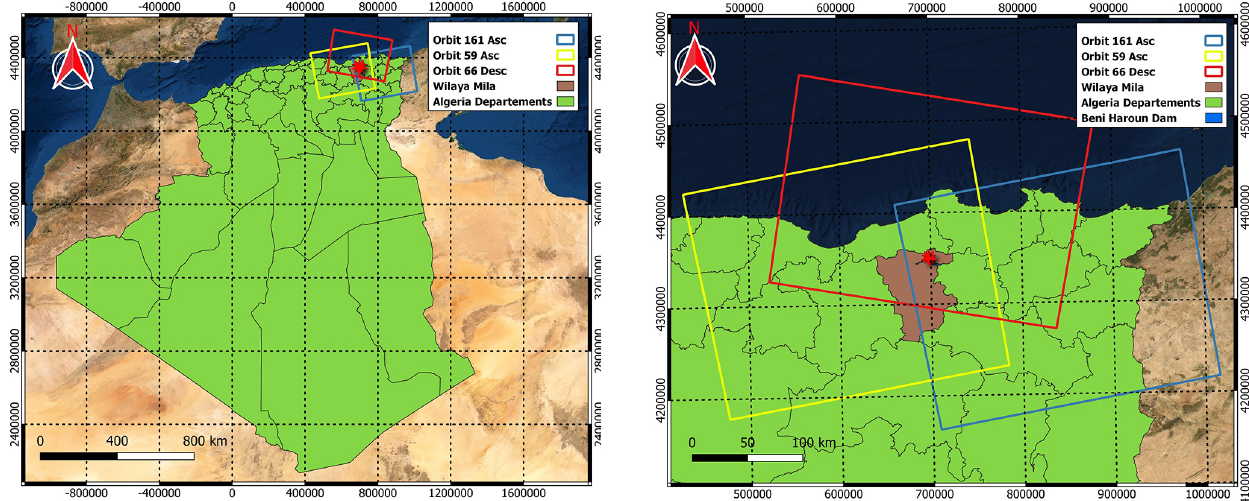
Figure 1. Mila location map (left panel), ascending and descending orbit footprints. Red stars indicate earthquake epicenter (QGIS, ESRI basemap).